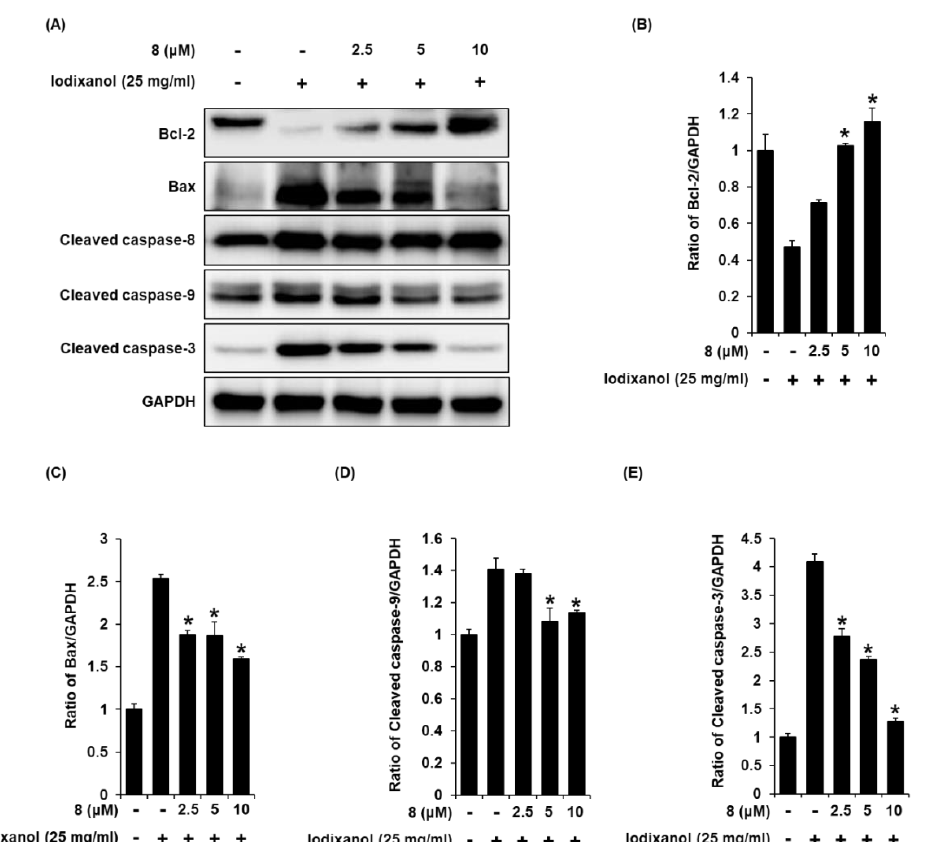
Figure 8. The effect of 3- epi- iso -seco -tanapartholide (compound 8 ) on the expression of Bcl-2, Bax, cleaved caspase-8, -9, and -3 proteins associated with apoptosis pathways in LLC-PK1 cells exposed to iodixanol. ( A ) LLC-PK1 cells were treated with 25 mg/mL iodixanol in the absence or presence of compound 8 , and western blot analysis was performed using antibodies for Bax, Bcl-2, cleaved caspase-8, -9, -3, and GAPDH. ( B – E ) The ratios of Bcl-2, Bax, cleaved caspase-9, and -3 compared with the untreated cells are represented as a bar graph (mean  SD, n = 3, * p <0.05 compared with iodixanol-treated LLC-PK1